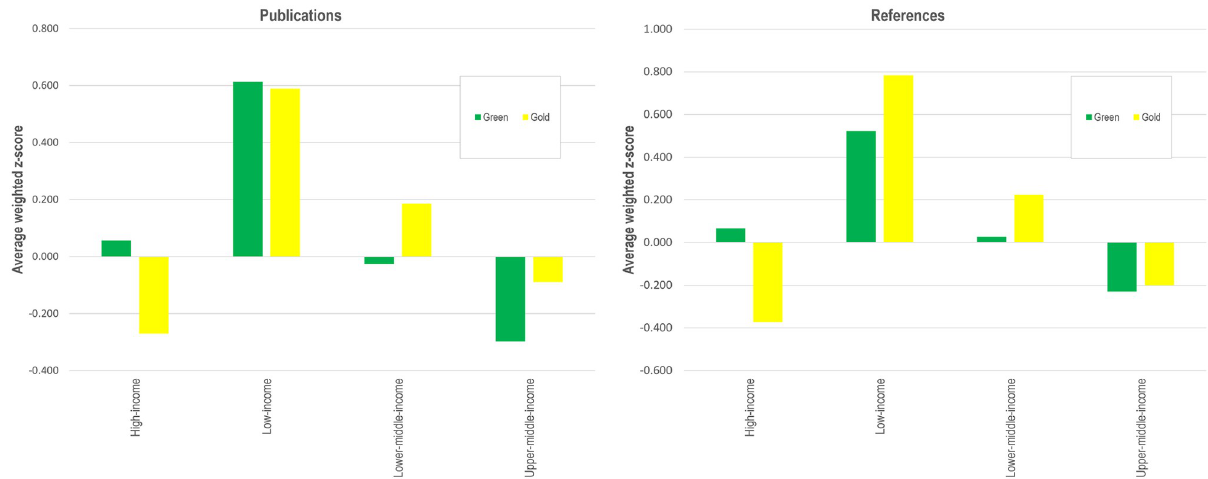
Fig 5. Average weighted z-score for green and gold OA publications (left) and references to green and gold OA publications (right) by income category.